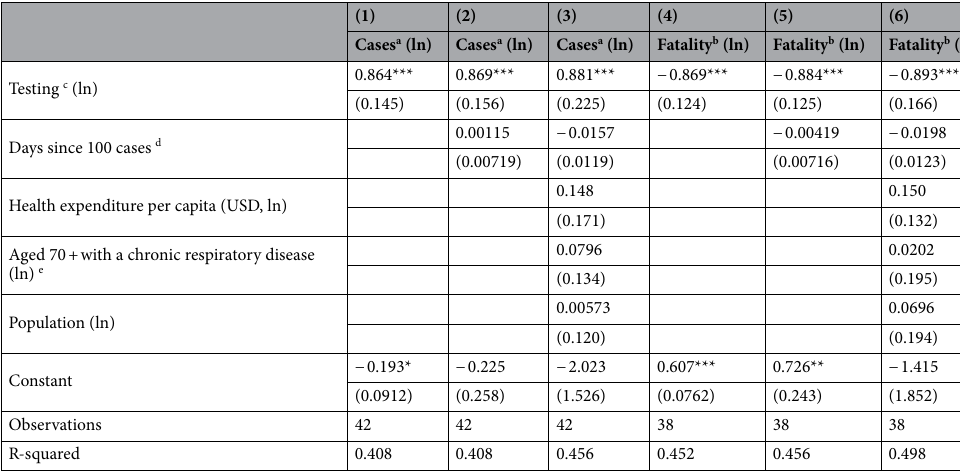
Table 1. Global regression estimates for the change in Covid-19 cases and case fatality rate reported on the change in tests conducted by country in a week. * p < 0.05, ** p < 0.01, *** p < 0.001. Robust standard errors in parentheses. ln stands for natural logarithm. a Confirmed cases of Covid-19 ″ during the week ending April 10th, 2020. b Case fatality rate is the ratio between deaths due to Covid-19 and cases in the same period. c Testing is the amount of negative and positive tests informed to each country’s health authority in the same period of cases 30 . d The number of days since the cumulated number of cases was equal to or greater than 100 1 . e Share of the population aged 70 or older with a chronic respiratory disease, including chronic obstructive pulmonary disease and asthma.